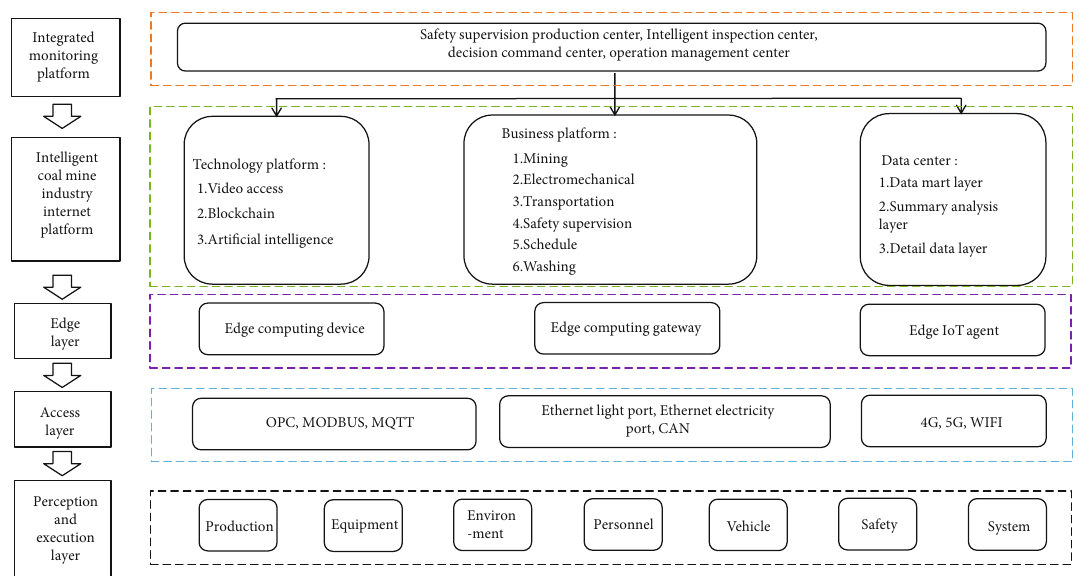
Figure 4: Reference technical framework for intelligent